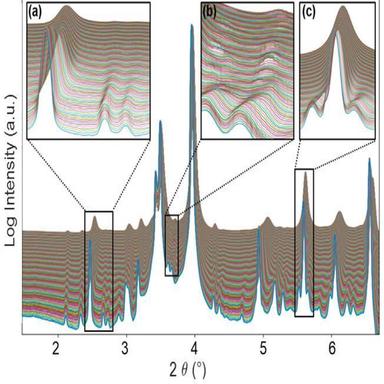
Waterfall plot of all the diffractograms acquired during the compression of A9Z2 at RT from bottom to top. The enlarged sections show the 2 ranges of (a) 2.39–2.83°, (b) 3.60–3.75° and (c) 5.45 5.70°.